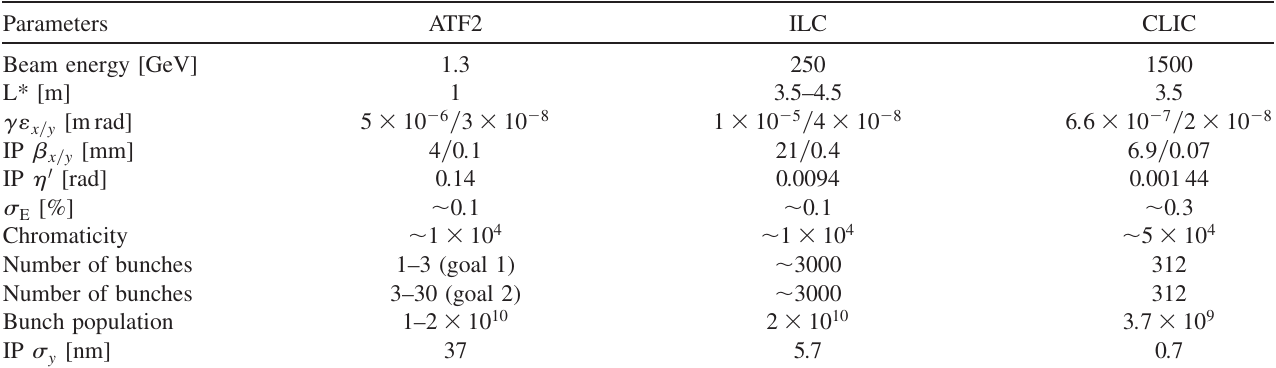
TABLE I. Comparison of ATF2 parameters with ILC and CLIC specifications.